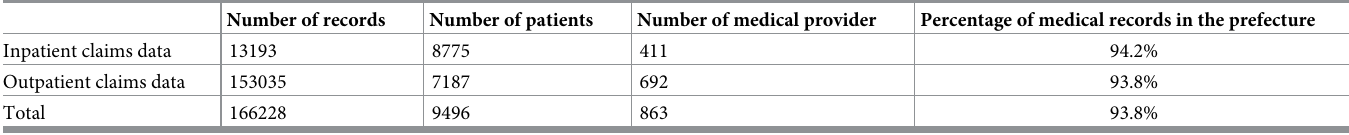
Table 1. Summary of patient claims